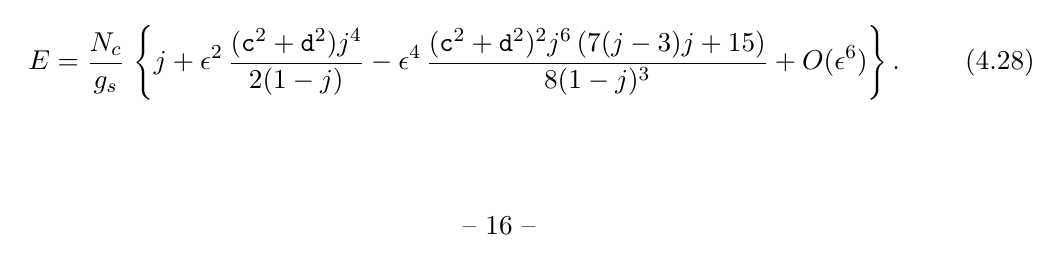
The parameters ( c , d ) are arbitrary constants of O (1) which may depend on (cid:15) . The energy of an oscillating D3 brane